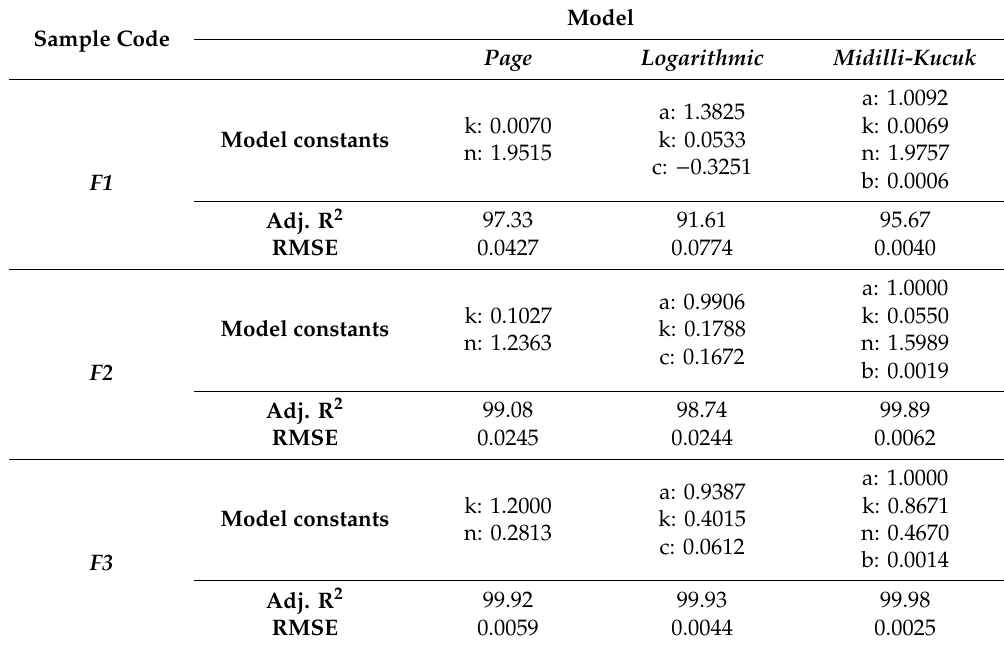
Table 2. Values of the freeze-drying kinetic parameters obtained for the three grapefruit formulations (F1, F2, and F3) when the Page, logarithmic and Midilli-Kucuk models were used to fit the